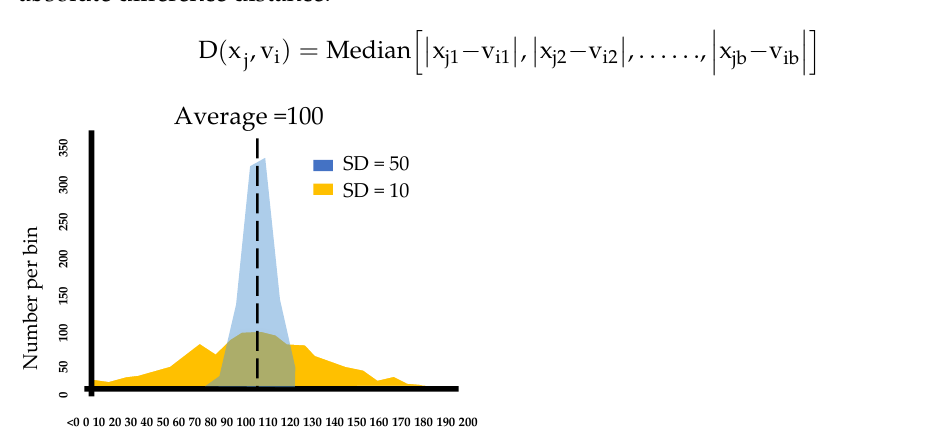
Figure 7. Schematic diagram of Median Absolute Difference Distance Measures.